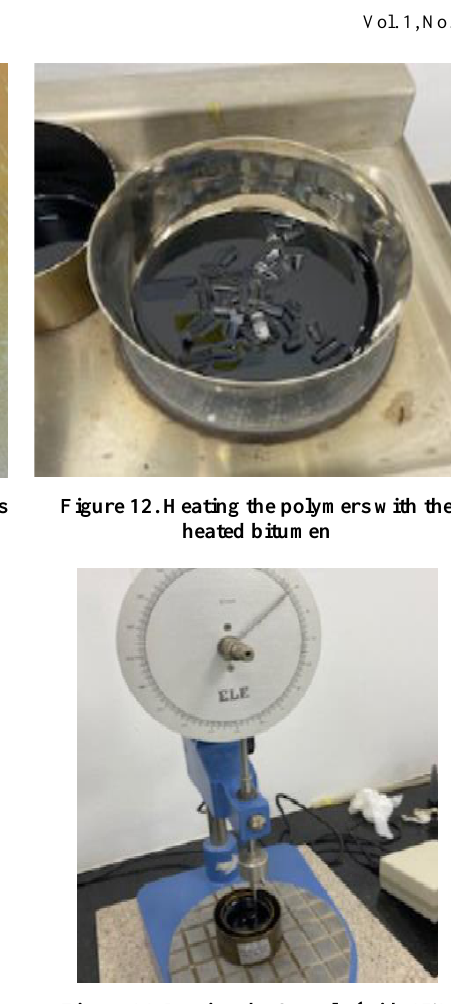
Figure 14. Putting the Sample (with 15% Polymer) in the penetration